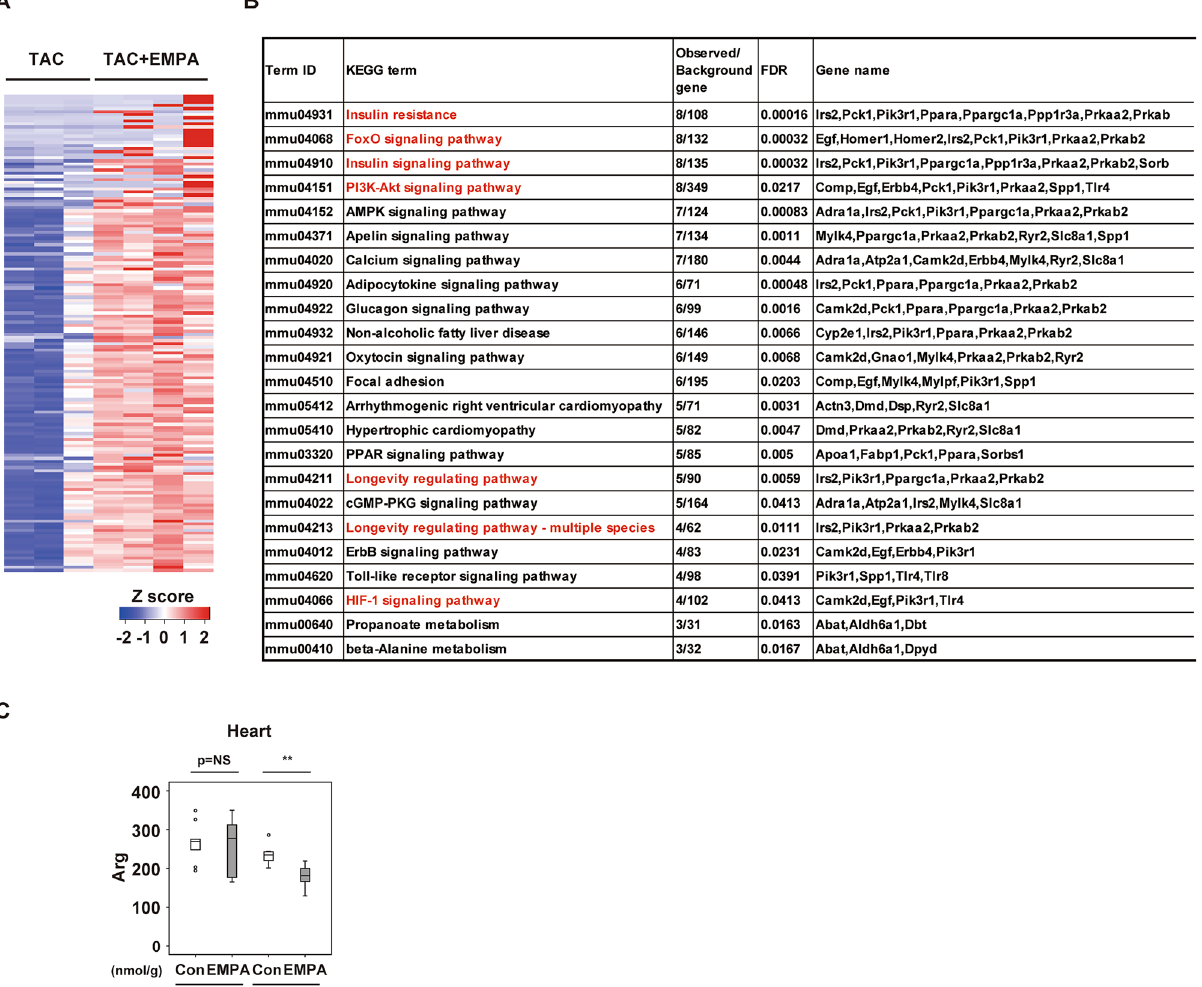
Figure 3. Results of RNA seq studies analyzing LV with EMPA administration. ( A , B ) RNA seq analysis data for cardiac tissues: Heat map ( A ) or KEGG categories enriched by twofold (q < 0.05, Benjamini–Hochberg correction for multiple-testing) in mice with empagliflozin (EMPA) administration and TAC (TAC + EMPA) as compared with mice with TAC only ( B ; n = 3, 4). For this study, cardiac tissues were collected 5 days after the introduction of EMPA at TAC2w, and samples were collected at TAC2w + 5 days. ( C ) Metabolomic study analyzing arginine (Arg) in cardiac tissues of indicated mice (n = 10, 10, 8, 9). For study in ( C ), 1 outlier (in TAC + Con group) was excluded by boxplot (SPSS) for further statistical analysis (n = 10, 10, 7, 9 were analyzed). Data were analyzed by 2-way analysis of variance (ANOVA) followed by Dunnett’s test ( C ). * P < 0.05, ** P < 0.01. Values are shown as the mean ± SEM. NS = not significant. Small circle indicates outlier, triangle indicates abnormal value. Analyses were performed with and without these values; when the results of both analyses were nonsignificant, the difference was described as